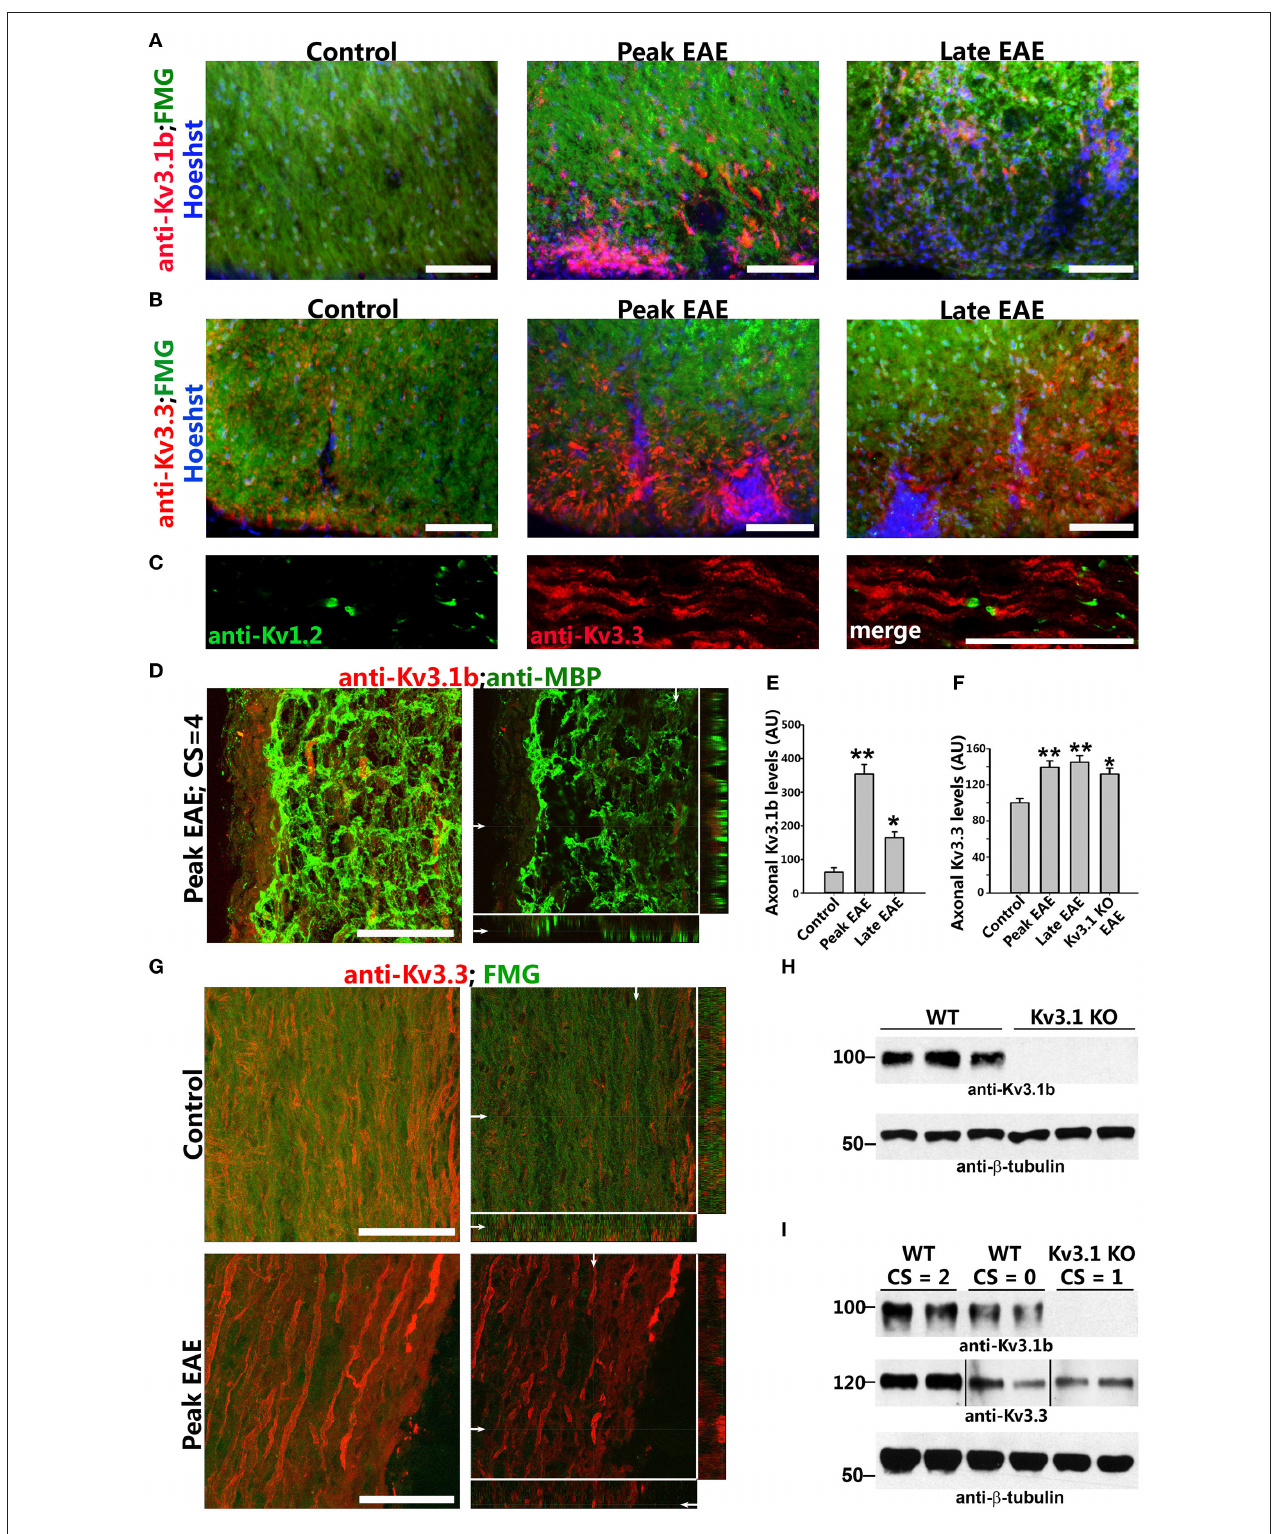
FIGURE 3 | Axonal Kv3.1 and Kv3.3 channels increased during EAE progression. (A) , Cross sections of SC ventral funiculus in WT mice at the control, peak, and late EAE stages stained with FMG (green), Hoechst (blue), and an anti-Kv3.1b antibody (red). (B) Similar cross sections stained for Kv3.3 (red). (C) SC longitudinal section from a control mouse was stained for Kv1.2 (green) and Kv3.3 (red). (D) Upregulated Kv3.1 in axonal segments that were partially demyelinated (anti-Kv3.1b in red